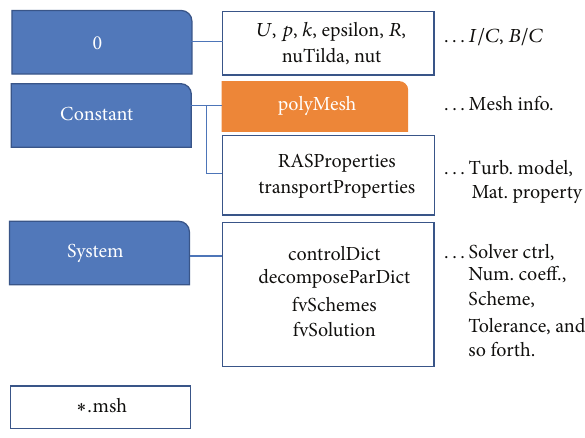
Figure 7: Schematic of the folder structure for OpenFOAM com-